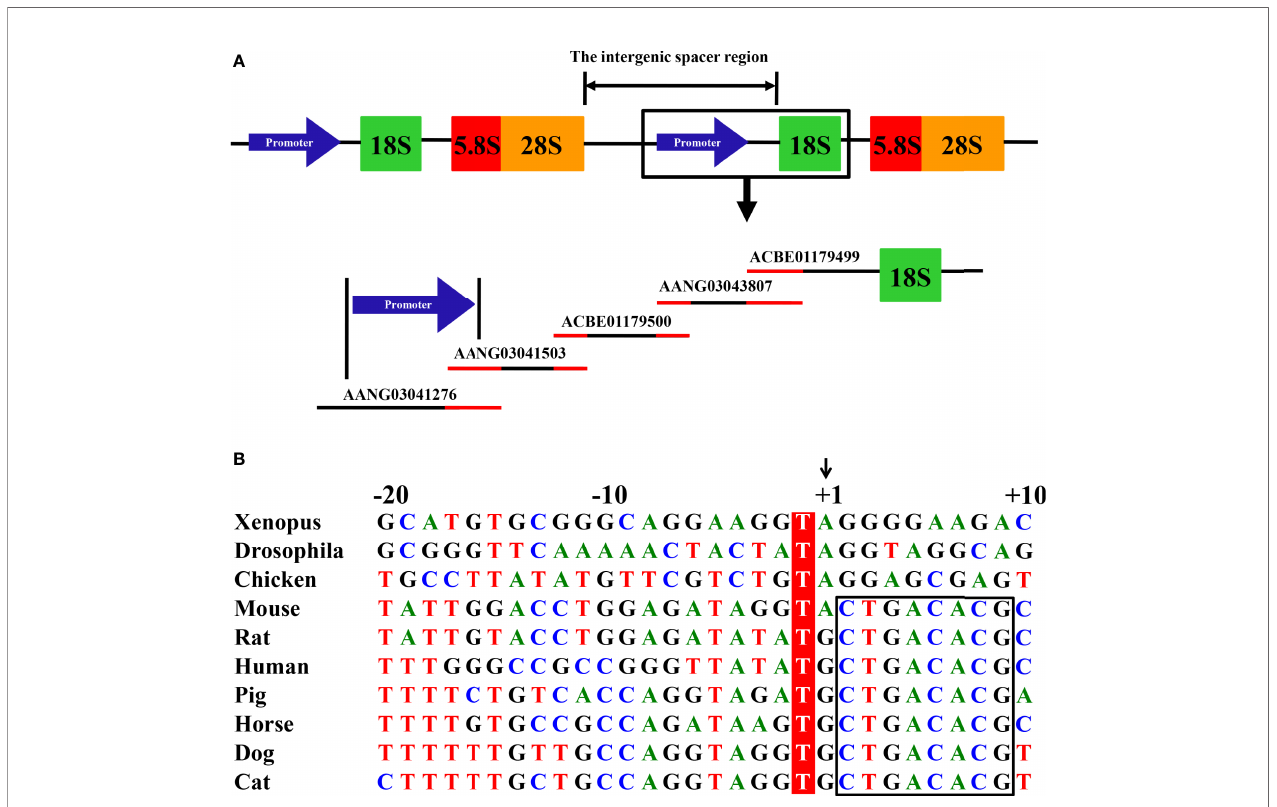
FIGURE 1 | Mapping of the feline RNA PolI promoter. (A) Eukaryotic 18S, 5.8S, and 28S rRNA genes are organized as clusters of head-to-tail repeats. After searching the cat genome, one contig, ACBE01179499, was con fi rmed to contain the cat 18S rRNA gene. Through homology comparison between four other contigs located upstream of the 18S rRNA in the cat genome, two contigs, AANG03041503 and AANG03041276, were predicted to contain the cat RNA PolI promoter. The homology region between the fi ve contigs is indicated in red. (B) Alignment of the nucleotide sequence from the -20 to +10 position of the predicted transcription initiation site of the feline RNA PolI promoter. The -1 position of the predicted transcription initiation site was conserved among all of the eukaryote species and was labeled in red. The predicted transcription initiation site is indicated by +1 and an arrow. The conserved +2 to +9 position among all of the mammals is indicated by a black